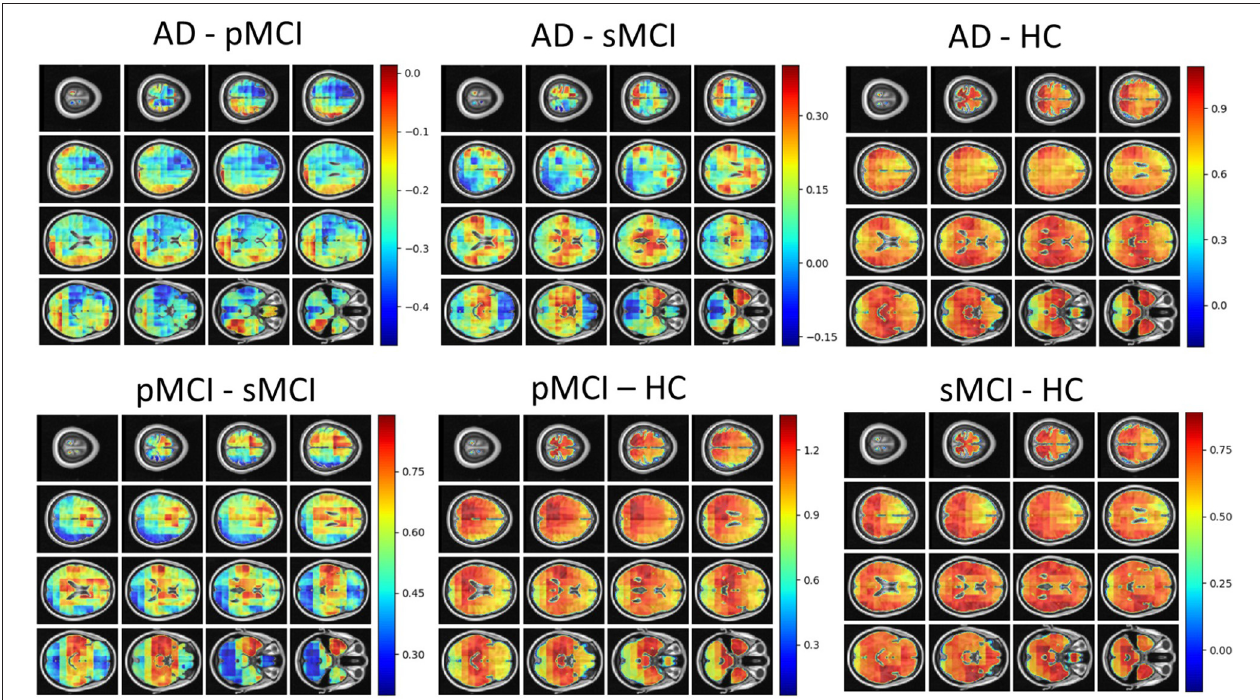
FIGURE 10 | Cohen’s d maps for different combinations of cross-sectional comparisons of clinical groups in OASIS3. Positive values indicate a positive effect for the first group. HC, Healthy Controls; pMCI, progressive MCI; sMCI, stable MCI; AD, Alzheimer’s Disease.